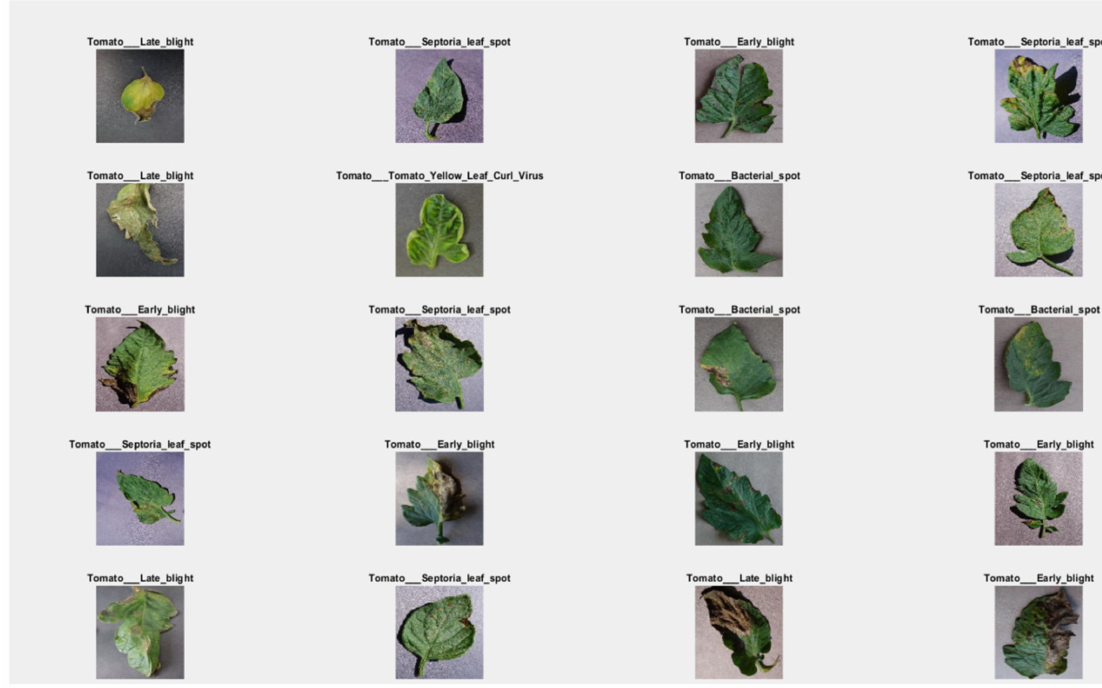
Figure 9. CNN model visual result.